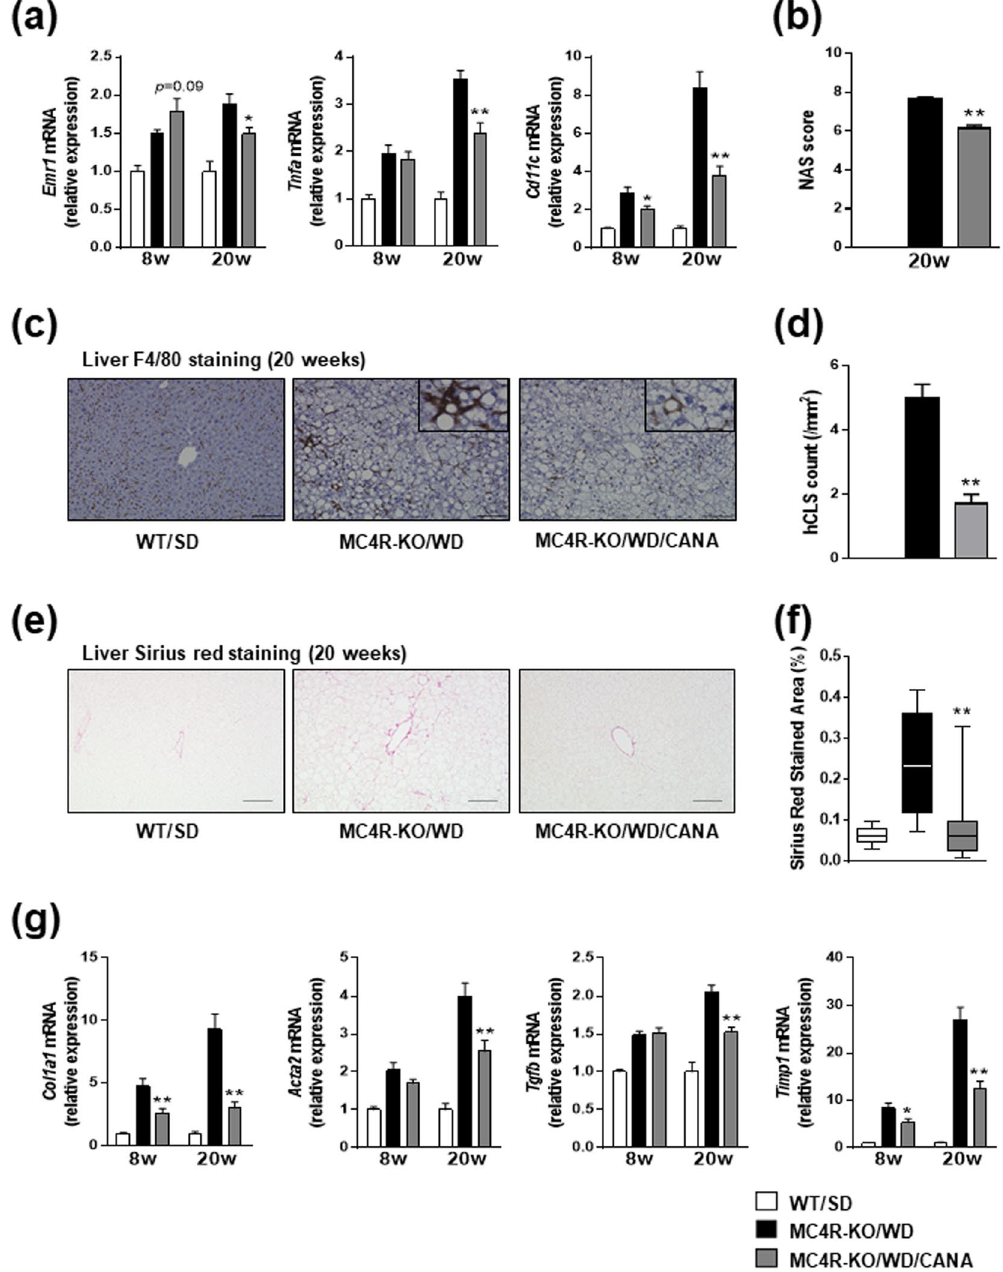
Figure 2. CANA inhibits hepatic inflammation and fibrosis in WD-fed MC4R-KO mice. ( a ) Expression levels of inflammation-related genes in the liver. ( b ) NAFLD activity score (NAS). ( c ) F4/80 immunohistochemical analysis of the liver. ( d ) Quantification of the number of hepatic crown-like structure (hCLS) in the liver. ( e ) Sirius red staining of the liver sections and ( f ) quantification. ( g ) Expression levels of fibrosis-related genes in the liver. Original magnification, × 200. Scale bars, 100 μ m. * p < 0.05, ** p < 0.01 vs MC4R-KO/WD. Statistical analyses were performed using one-way ANOVA ( a , b , d and g ) or Kruskal‐Wallis test ( e ) followed by Bonferroni or Dunn post hoc test, respectively; MC4R-KO/WD and MC4R-KO/WD/CANA was pre-selected as a subset of means or medians to compare. n =